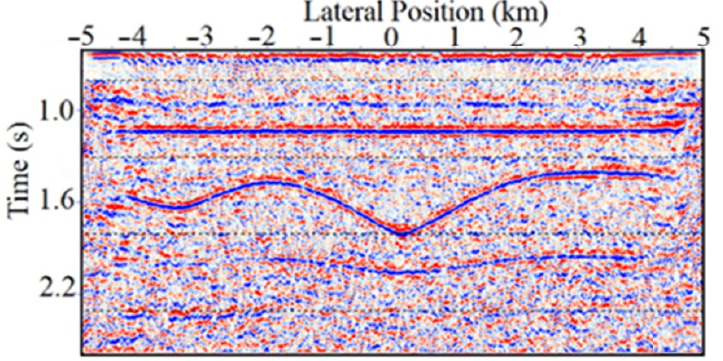
Figure 6. Stacked buried-geophone section after applying predictive and spiking deconvolution, and Radon transform filter. We note that the Radon transform significantly removes the surface multiples that remained in Figure 5 indicated by the arrows.